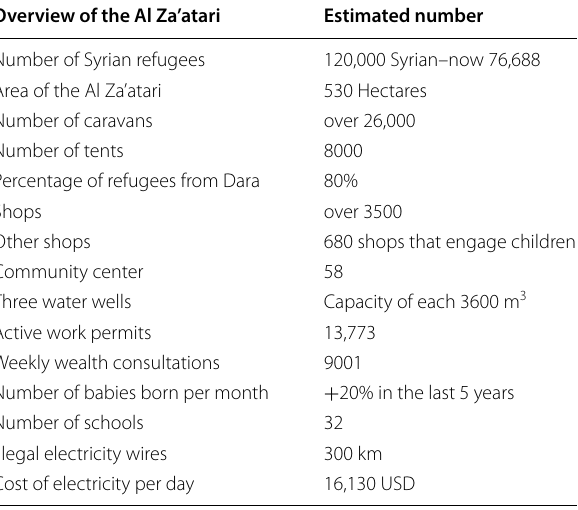
Table 1 The Al Za’atari by numbers and